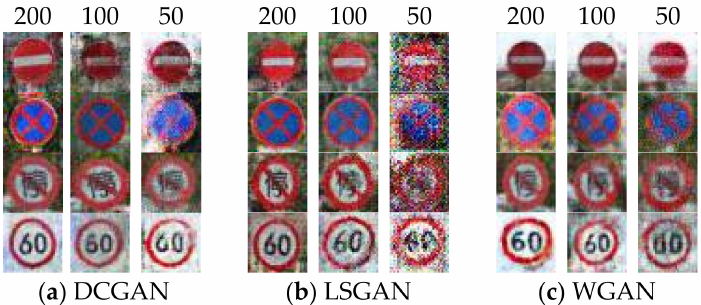
Figure 7. Synthetic traffic sign images of all classes with epoch 1000 and size 32 × 32 generated by